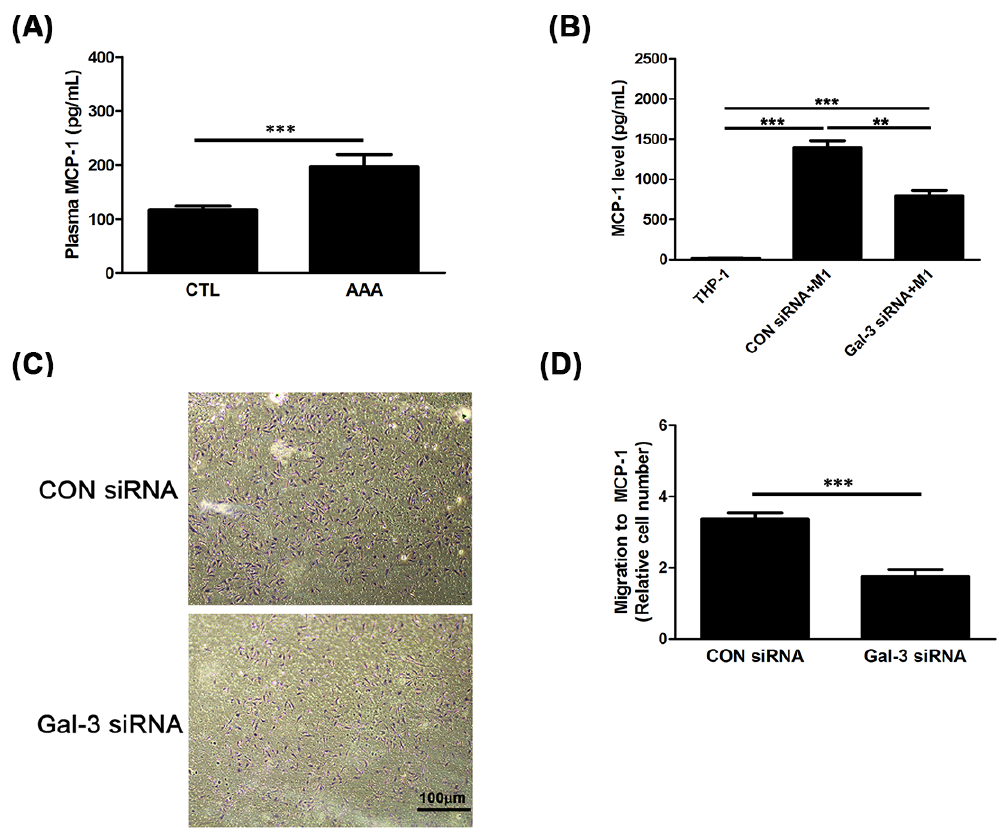
Figure 3. Gal-3 enhanced monocyte chemotaxis through of MCP-1 up-regulation. ( A , B ) ELISA was used for detection of MCP-1 concentration in human plasma and CM. ( C , D ) Representative images of transwell migration assays in response to MCP-1. M1 cells were stained with crystal violet and counted under microscope. The magnification was 100x. Data are expressed as mean ± S.E.M. for at least 3–4 independent experiments. ** p < 0.001, *** p < 0.0001.